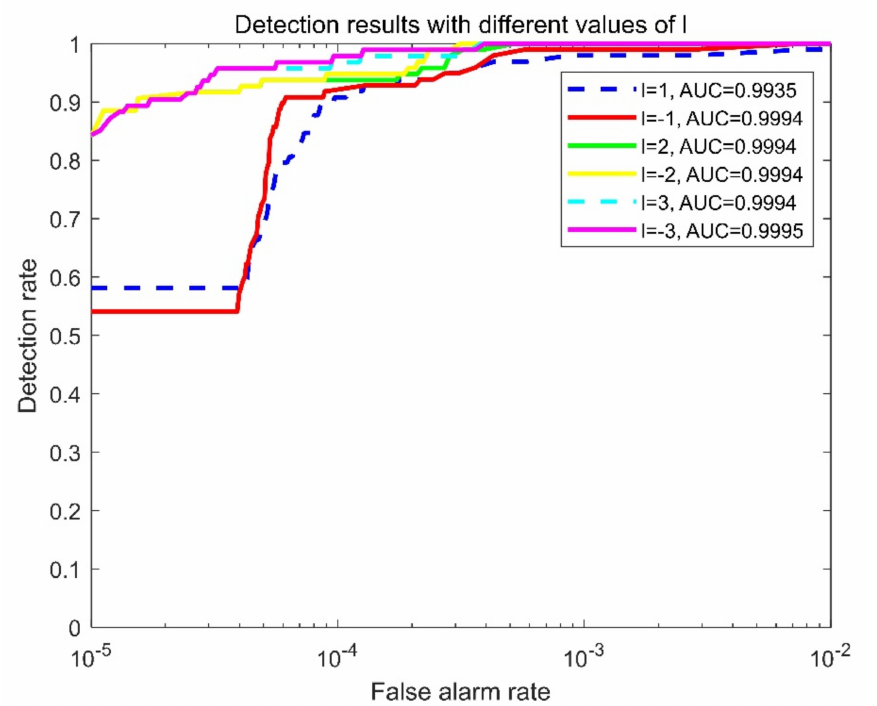
Figure 11. ROCs and AUC values with different frame intervals.